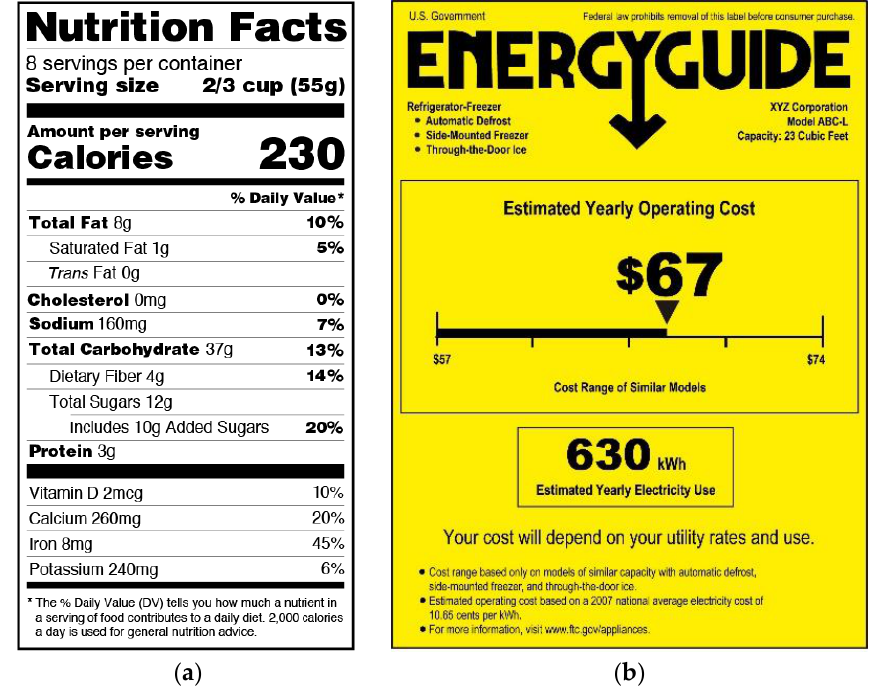
Figure 1. ( a ) Nutrition Facts label format (modified from [31]), left, and ( b ) energy guide label format [32], right.